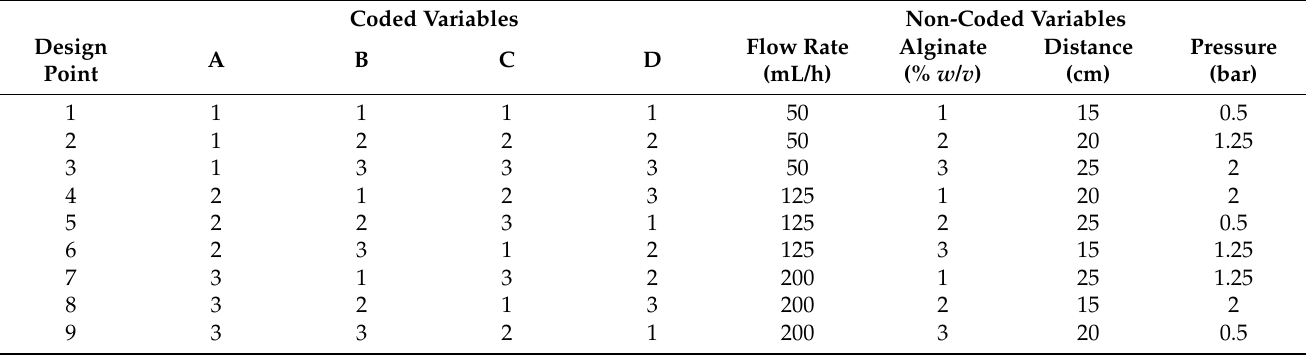
Table 1. Taguchi design for optimization of antigen microencapsulation